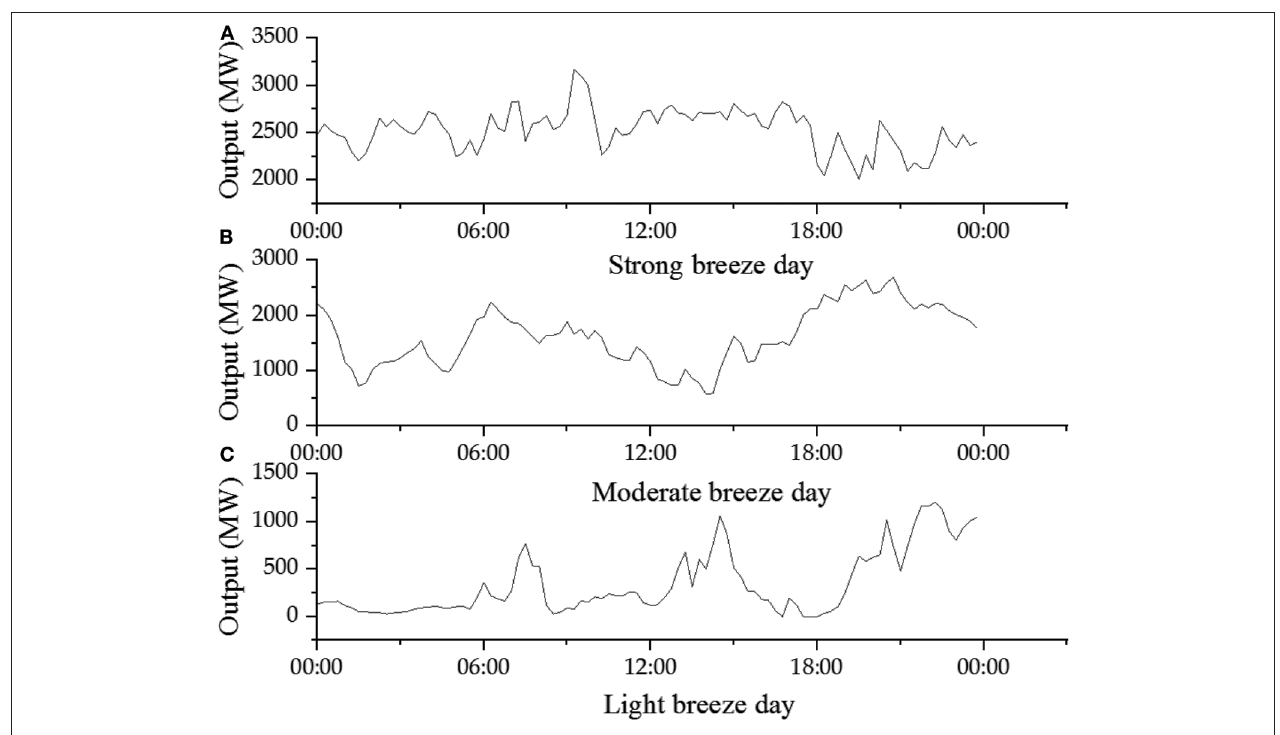
FIGURE 1 | Simulation curve of wind typical daily output of Guangdong in